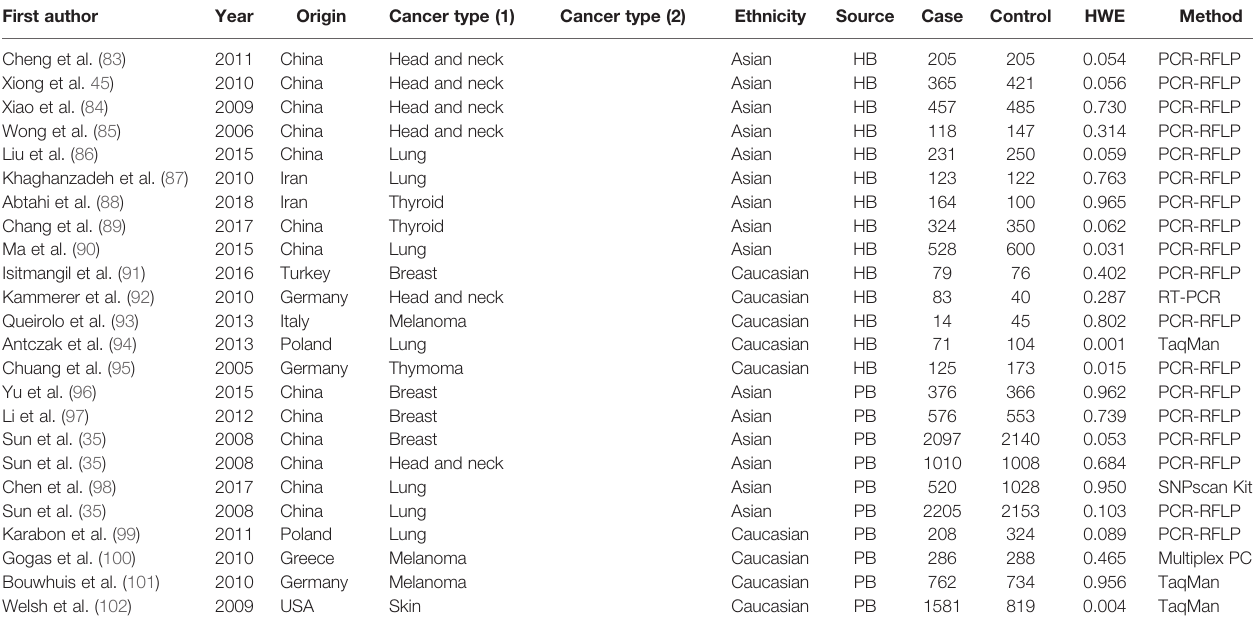
Using 29,464 cases and 35,858 controls, the overall risk of CTLA-4 rs231775 is summarized in Table 2 . CTLA-4 rs231775 polymorphism appears to decrease cancer risk in overall genetic models (G-allele vs. A-allele, OR = 0.94, 95%CI = 0.90-1.00, P heterogeneity < 0.001, P = 0.037; GG vs. AA, OR = 0.86, 95%CI = 0.76-0.96, P heterogeneity < 0.001, P = 0.010; GG vs. GA+AA, OR = 0.88, 95%CI = 0.82-0.94, P heterogeneity < 0.001, P < 0.001). There were signi fi cant associations between CTLA-4 polymorphisms and two types of cancers (colorectal cancer: GA vs. AA, OR = 1.72, 95%CI = 1.13-2.60, P heterogeneity < 0.001, P = 0.011; GG +GA vs. AA, OR = 1.52, 95%CI = 1.08-2.15, P heterogeneity < 0.001, P = 0.017, Figure 4 ; thyroid cancer: G-allele vs. A-allele, OR = 1.50, 95%CI = 1.22-1.85, P heterogeneity = 0.134, P < 0.001). On the other hand, signi fi cantly decreased associations were detected in six kinds of cancer (breast cancer: G-allele vs. A-allele, OR = 0.84, 95%CI = 0.78-0.90, P heterogeneity = 0.221, P < 0.001, Figure 5 ; liver cancer: G-allele vs. A-allele, OR = 0.89, 95%CI = 0.82-0.98, P heterogeneity = 0.151, P = 0.018; cervical cancer: G- allele vs. A-allele, OR = 0.88, 95%CI = 0.78-0.99, P heterogeneity = 0.023, P = 0.028, Figure 6 ; bone cancer: GG+GA vs. AA, OR = 0.61, 95%CI = 0.38-0.99, P heterogeneity < 0.001, P = 0.044, Figure 7 ; head and neck: G-allele vs. A-allele, OR = 0.79, 95% CI = 0.69-0.91, P heterogeneity = 0.031, P =0.001, Figure 8 ; pancreatic cancer: G-allele vs. A-allele, OR = 0.72, 95%CI = 0.57-0.91, P heterogeneity = 0.049, P = 0.006).